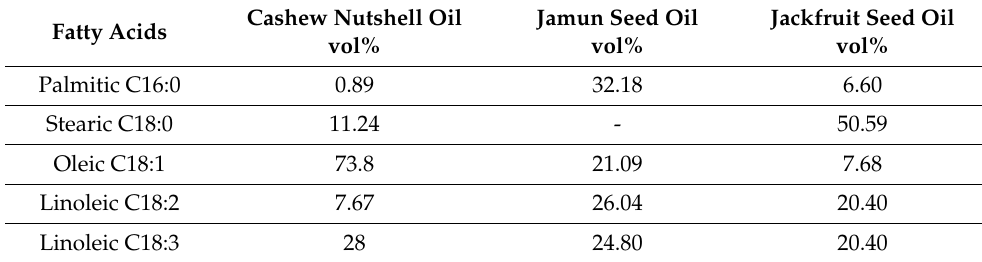
Table 1. Fatty acid compositions of nonedible oils [42].